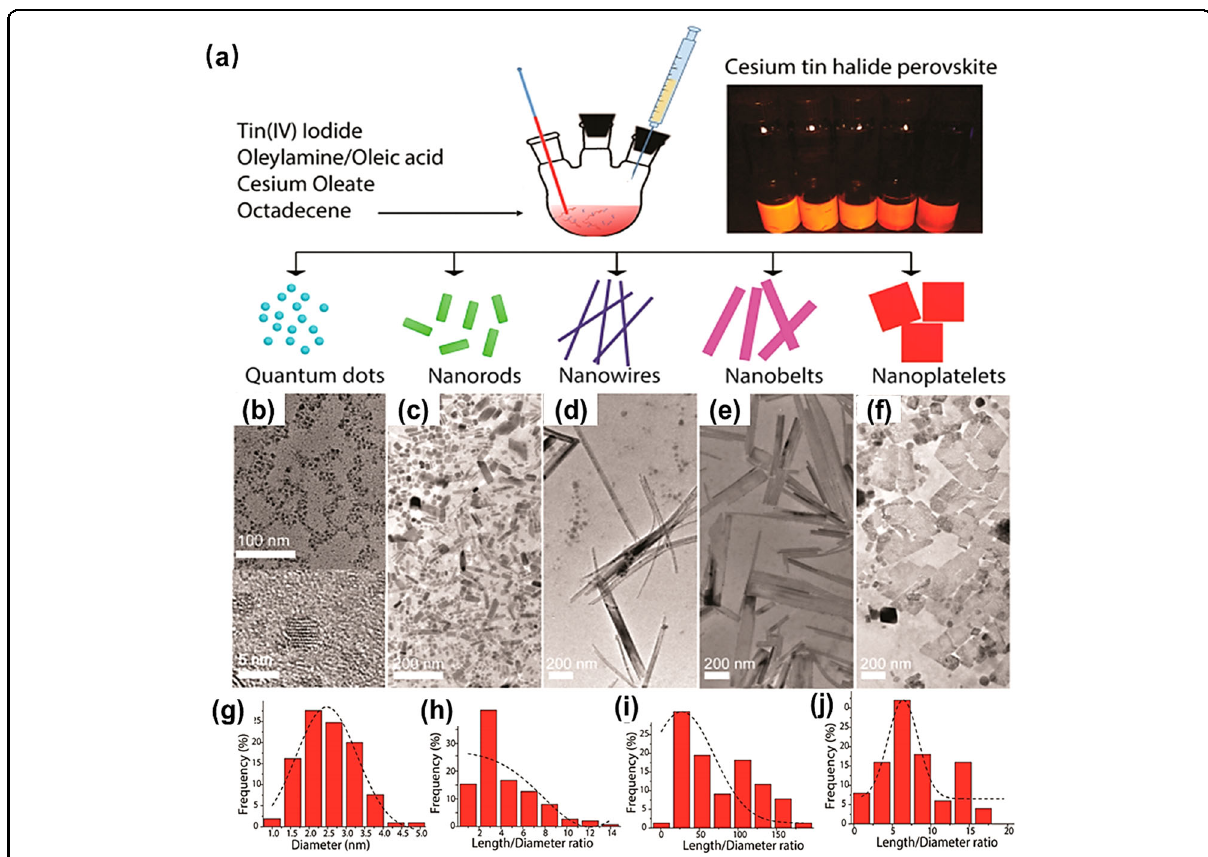
Fig. 4 Growth of 1D morphological MHP by hot-injection methods. a Scheme showing the synthesis of Cs 2 SnI 6 and samples exposed to UV light. b-f TEM images of Cs 2 SnI 6 . g Histogram showing the particle size distribution corresponding to Fig. 4b. h – j Histograms showing the diameter- length ratios for the samples in Fig. 4c – e. Reproduced with permission from ref. 58 . Copyright 2016, American Chemical